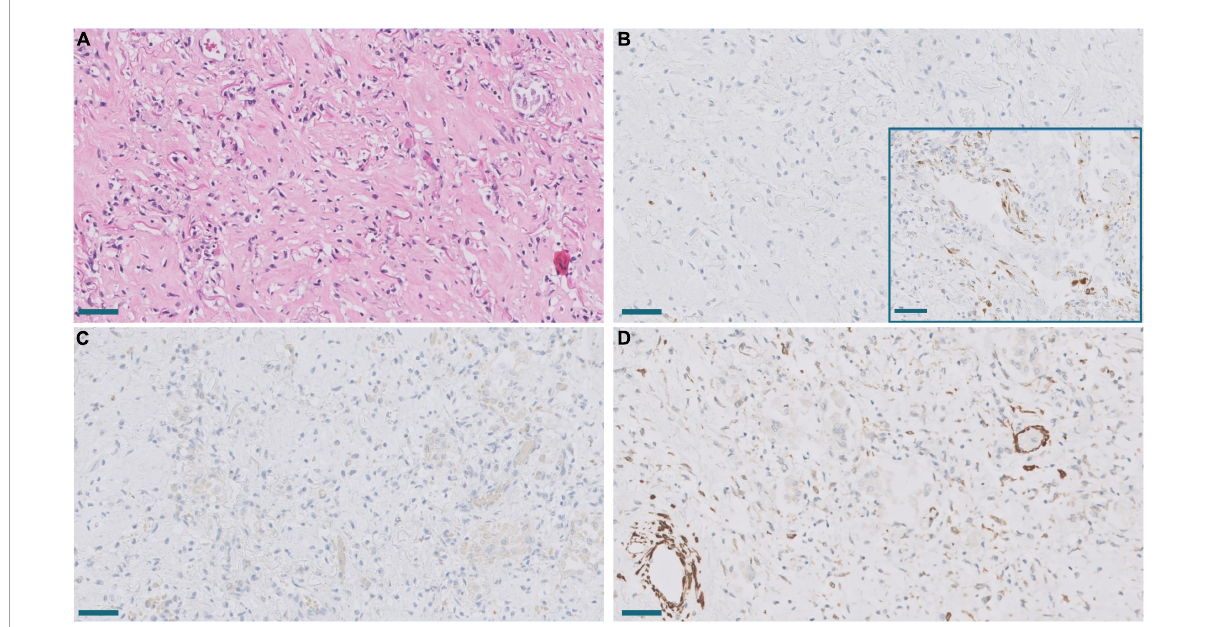
FIGURE9 (A) Established area of mature fibrosis (HE). Scale bar: 100 µ m. (B) Lack of expression of SPARC in mature fibrosis in contrast to moderate SPARC expression in an active proliferative area (inset). Scale bar: 100 µ m. (C,D) . Lack of CTHRC1 expression (C) and diminished α -muscle actin expression (D) in the same fibrotic area. Scale bar: 100 µ m.